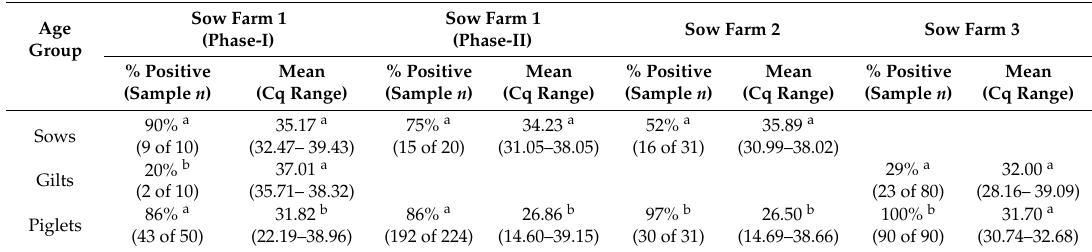
Table 1. Distribution of detection of porcine astrovirus type 3 (PoAstV3) in fecal samples across various age groups across farms by RT-qPCR.